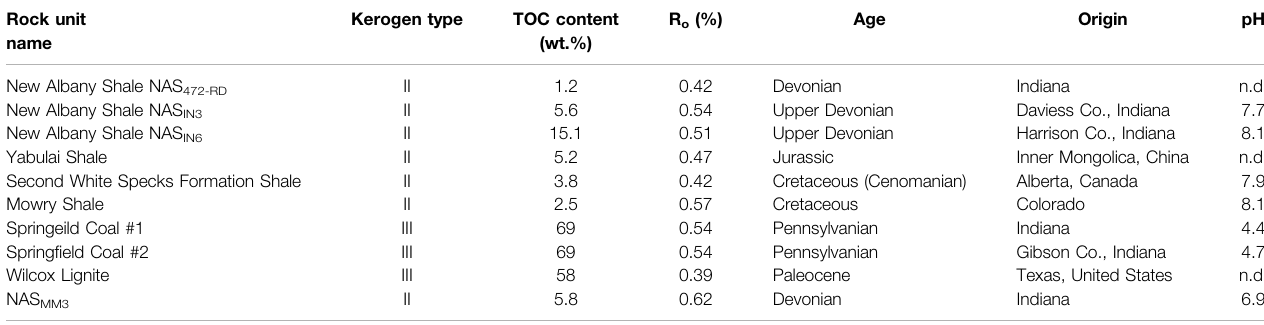
TABLE 1 | Low-maturity source rock starting materials: kerogen type, total organic carbon (TOC) content, maturity (expressed by vitrinite re fl ectance R o ), age, and geographic origin. The pH values were measured in water in contact with the powdered original rock.